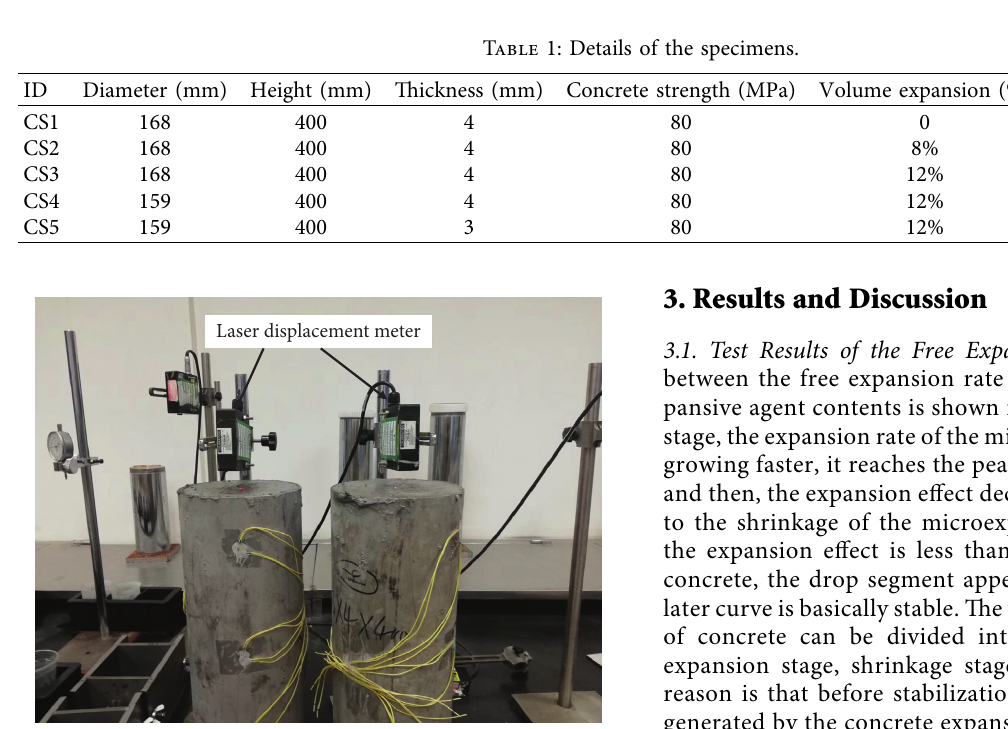
Figure 1: Axial free expansion test device.